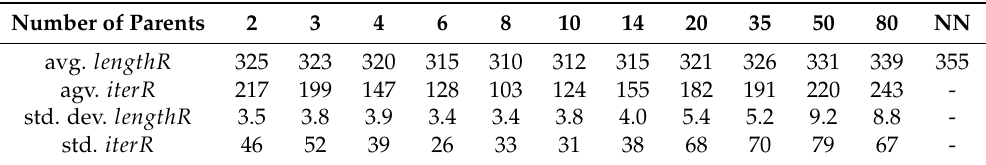
Table 2. A sample route length lengthR and number of iterations iterR to obtain this length for a modified multi-parent HGreX crossover operator for an order of 60 products with fixed product placement (averages of 10 runs). NN in the last column denotes the result obtained for the Nearest Neighbor Algorithm.